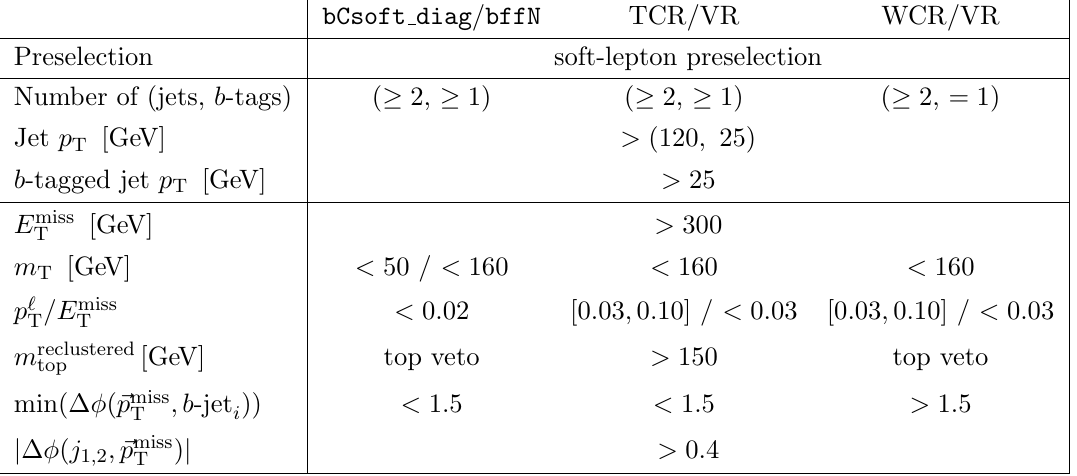
Table 20 . Overview of the selections for the bCsoft diag and bffN signal regions, as well as the associated control regions for t (cid:22) t (TCR) and W +jets (WCR), and the validation regions targeting t (cid:22) t (TVR) and W +jets (WVR) backgrounds. List values are provided in between parentheses and square brackets denote intervals. The veto on the reclustered hadronic top-quark candidate is satis(cid:12)ed for events where no reclustered jet candidate is found, or where the mass of the hadronic top-quark candidate ( m reclustered ) is below a certain threshold. The leading jet is required not to top be b -tagged in all